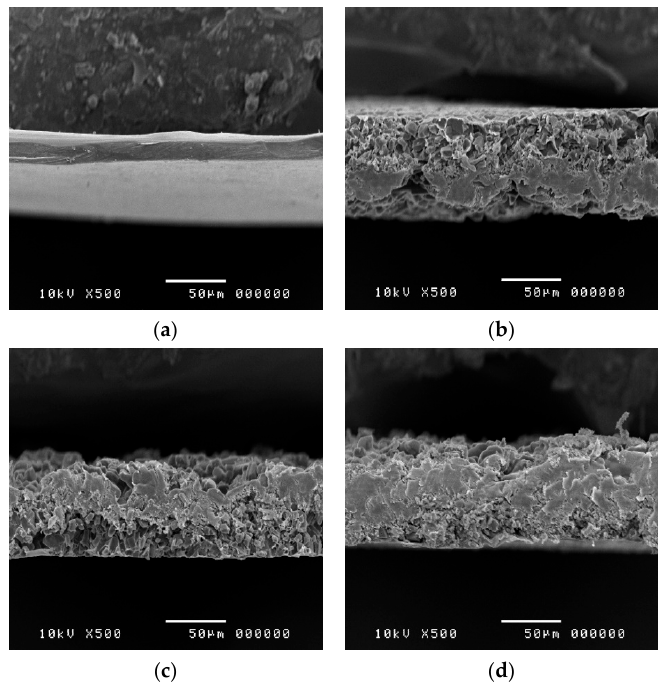
Figure 4. Scanning electron microscopy images of E15 ( a ), E15 ‐ PT ( b ), E15 ‐ PT ‐ PG ( c ) and E15 ‐ PT ‐ G ( d